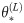
Genetic potential increases around the bistable region at high nonlinearity.(A) The f(A) function for some solution genotypes are shown (see row and column titles) exemplifying cases where (1) both θ*(L) and θ*(H) are monostable (i.e. the associated f(A) and γ ⋅ A intersect only once; all examples with nH = 1, and {nH = 16, KD = 1}), (2) a bistable solution genotype with k*(L)≈k*(H) ({nH = 16, KD = 50}, f(A) and γ ⋅ A intersect both in A = 20 and A = 80, with an unstable steady state between these steady states), and (3) only θ*(H) is bistable, and not a solution for the LOW environment ({nH = 16, KD = 120}). (B) Solution genotypes θ*(E) per environment were calculated (Eq 8). (C) The maximum genetic potential for different values of KD and nH (i.e. min(dM(θ*(L)),dM(θ*(H)))|{nH,KD}) is shown in the colormap. As reference, the bistable solution genotypes for each environment are delimited by the green lines: θ*(L) as dark green, and θ*(H) as light green. Additionally, we show as an example the population average KD and nH per cycle for ten simulations over 10000 generations with k = 80, nH = 1, and KD = 10 as the initial genotype (red circle, θ0), and evolutionary parameters N = 10000, u = 0.03, M = 1.1, ν = 0.10, and st = 40 (black lines), and the equivalent CONTROL simulations (i.e. without biochemical noise; gray lines). The colorbar shows the one-mutation distance corresponding to each value of M.